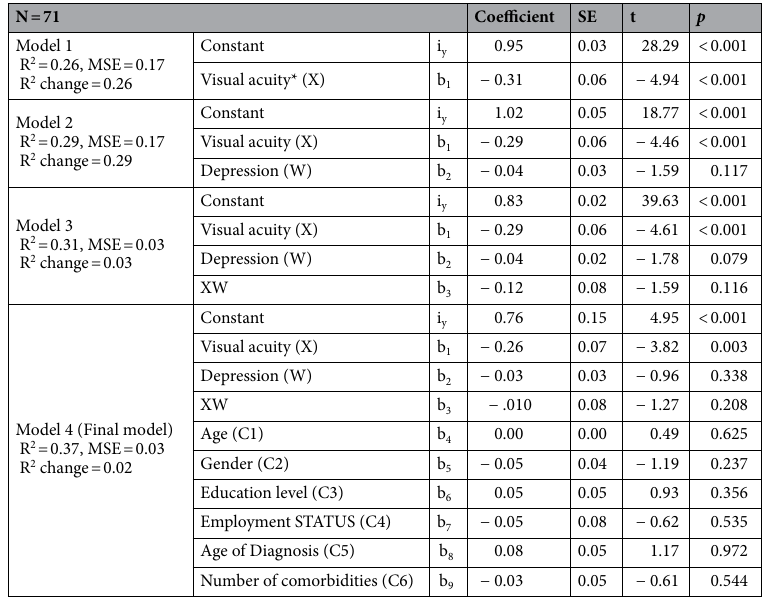
Table 6. Stepwise moderation analysis with depression (W) as moderator of the relationship between visual acuity (X) and health-related quality of life (Y). *Presenting distance visual acuity in the better eye (logMar values); categorical variables: gender (female; male); education level (up to 9 years of education; more than 9 years of education); employment status (Full-time work; retirement); age of diagnosis (up to 1 year; more than 1 year); number of comorbidities (up to 1; 2 or